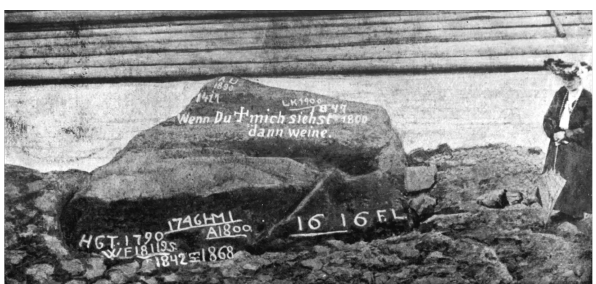
Fig. 2. The “hunger stone” at the left bank of the River Elbe at Dˇeˇc´ın-Podmokly (Br´azdil and Kotyza,